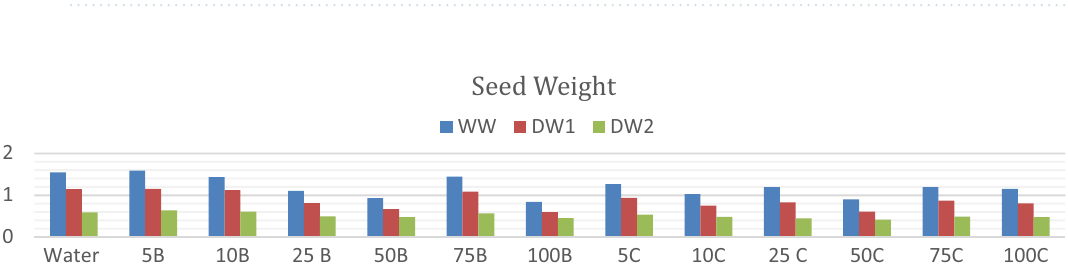
Figure 6. Effect of different concentration of ZnO nanoparticles on the seed germination weight ( WW wet weight, DW1 dry weight day 1, DW2 dry weight day